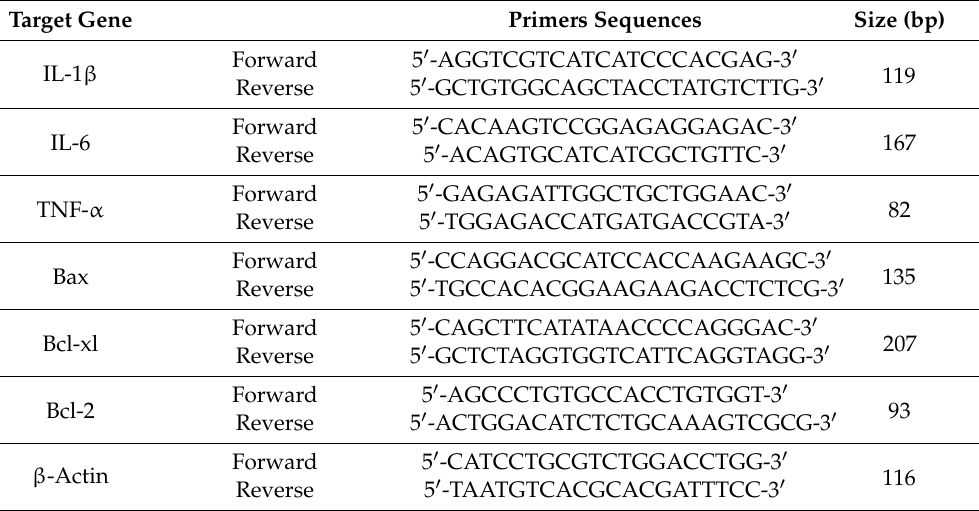
Table 1. Primers used in real-time PCR analyses of mRNA